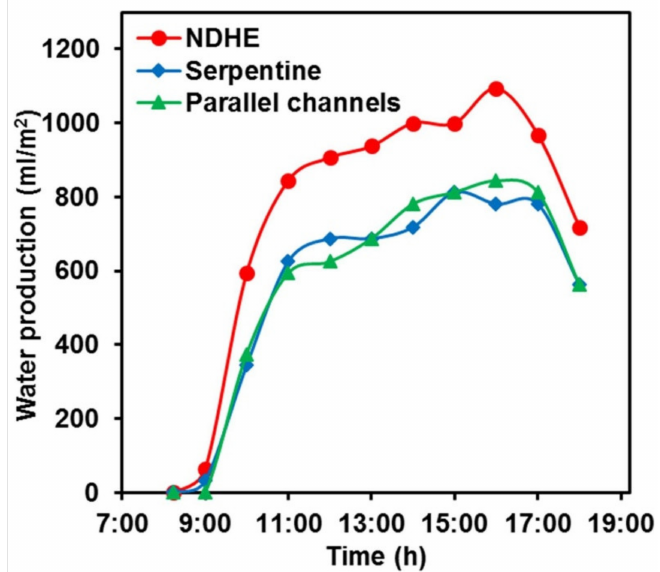
Figure 6. Hourly variation of water production for different heat exchangers